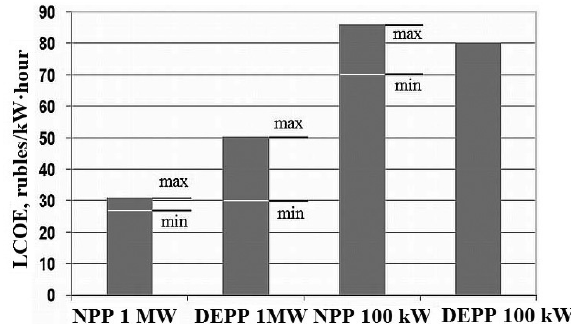
Figure 2. Estimated Levelized Cost of Energy (LCOE) for mega- watt-class power plants in the Arctic (NPP – nuclear power plant).